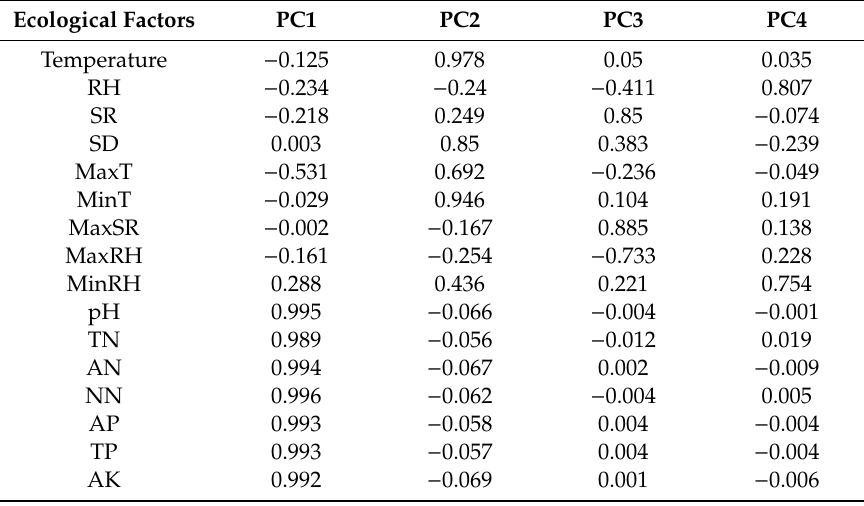
Table 3. Component analysis matrix of the principal components.